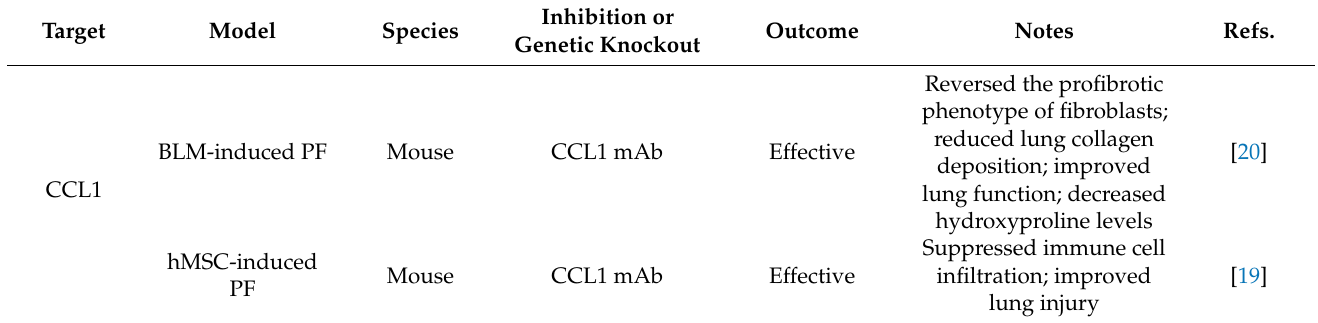
Table 1. Targeting chemokine pathways in animal models of PF and human